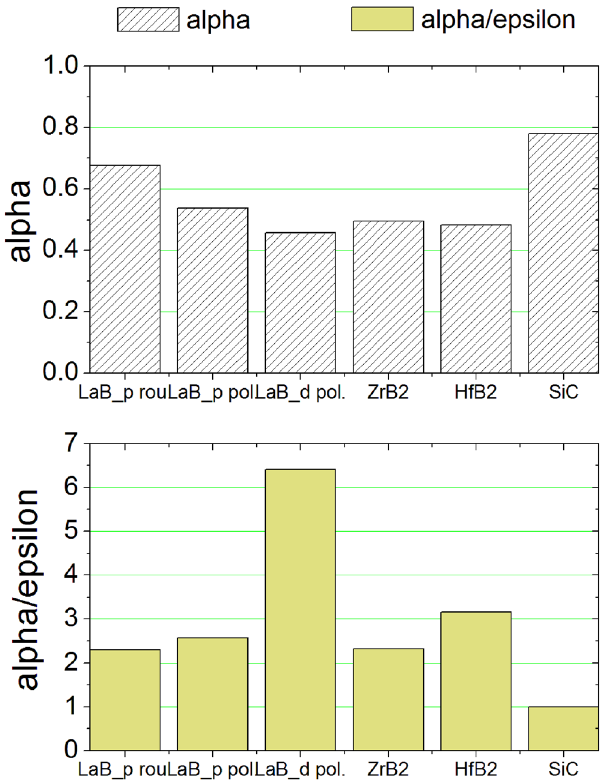
Figure 4. Calculated solar absorbance α and solar selectivity α / ε for LaB 6 samples and comparison with HfB 2 ,